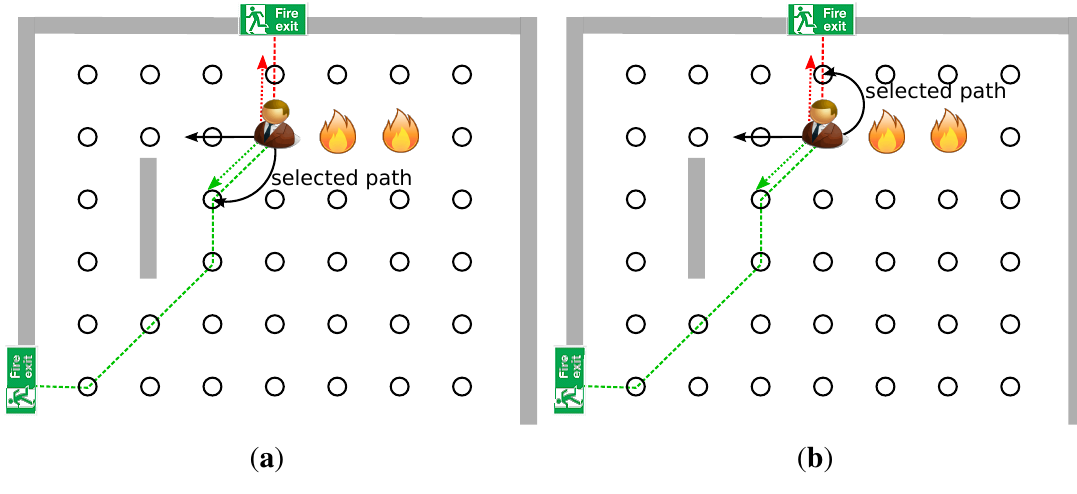
Figure 2. An evacuation where Equation (2) does find a suboptimal path. ( a ) An example where the Equation (2) does not find the optimal path; ( b ) And with the uncertainty factor (Equation